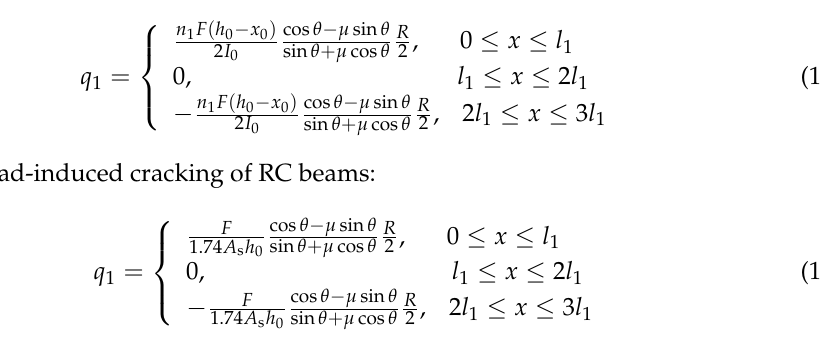
Figure 4. RC beams under the third-point concentrated load. Substituting Equation (11) into Equations (9) and (10), respectively, the tensile stress of ribbed steel bars can be obtained, and then Equation (5) can be rewritten as: Before load-induced cracking of RC beams: